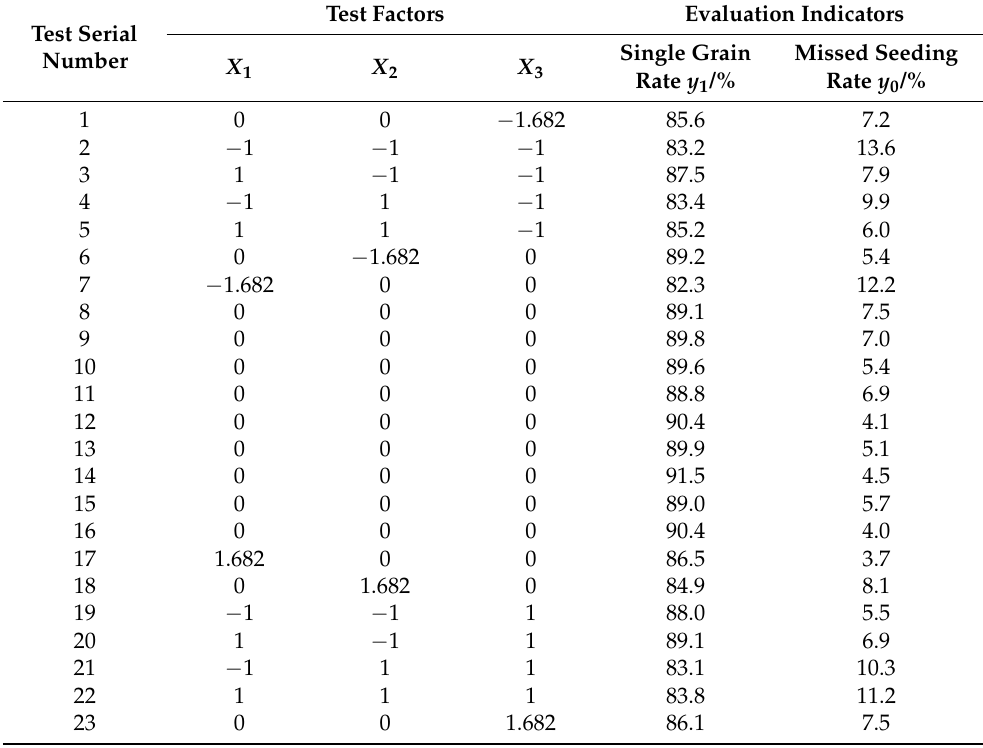
Table 3. Combined test protocol and results for secondary rotation orthogonal